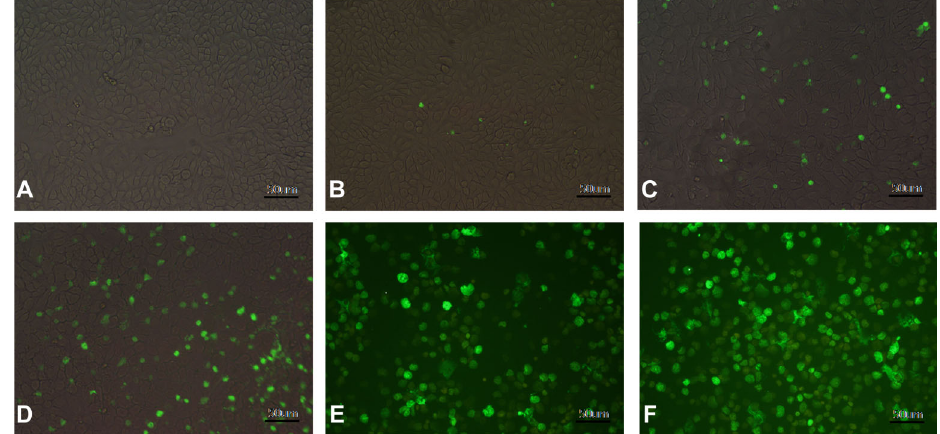
Figure 6. Apoptosis of SMMC-7721 cells (200 6 ) after treatment. A , Control group (RPMI 1640 culture medium only); B , spiking group (8 g/L Fe 2 O 3 , no radiation); C , 2 g/L Fe 2 O 3 MFH group; D , 4 g/L Fe 2 O 3 MFH group; E , 6 g/L Fe 2 O 3 MFH group; F , 8 g/L Fe 2 O 3 MFH group. MFH: magnetic fluid